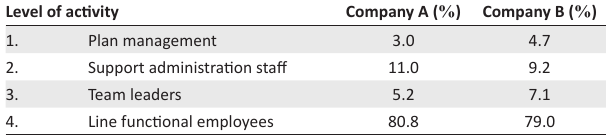
TABLE 1: Percentage breakdown of employees in terms of their level of